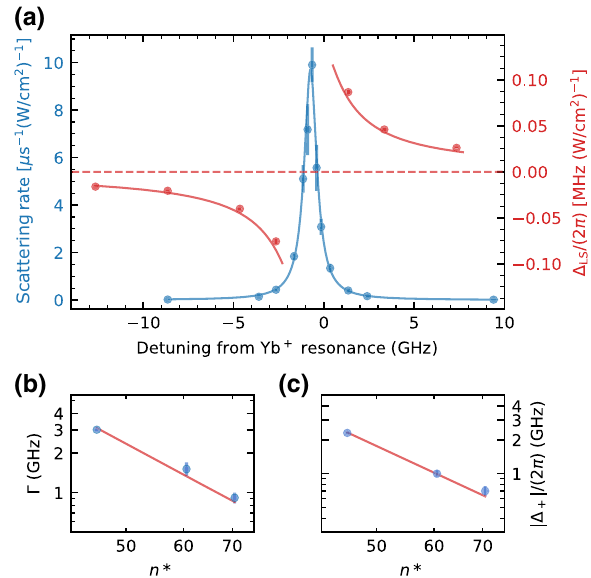
FIG. 2. (a) (cid:3) LS /( 2 π) (red) and (cid:4) LS (blue) for the 6 s 75 s 3 S 1 state, as a function of the control-beam detuning from the Yb + 6 s → 6 p 1 / 2 transition frequency, f + . The lines are fits to the expressions in the text. (b) The extracted linewidth, (cid:4) and (c) center frequency offset (cid:3) + as a function of n ∗ = n − δ with δ = 4.439 [24]. A fit to ( n ∗ ) − 3 is included from which we extract the following: (cid:4)( n ∗ ) = 2 π × 2.9 × 10 14 s − 1 / n ∗ 3 and ( n ∗ ) | /( 2 π) = 2.2 × 10 14 Hz / n ∗ 3 | (cid:3) +